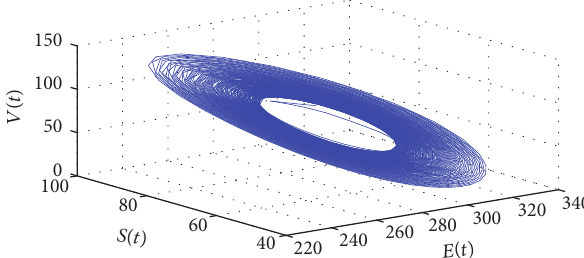
Figure 15: The projection of the phase portrait of system (69) in (𝑆,𝐸, 𝑉) -space with 𝜏